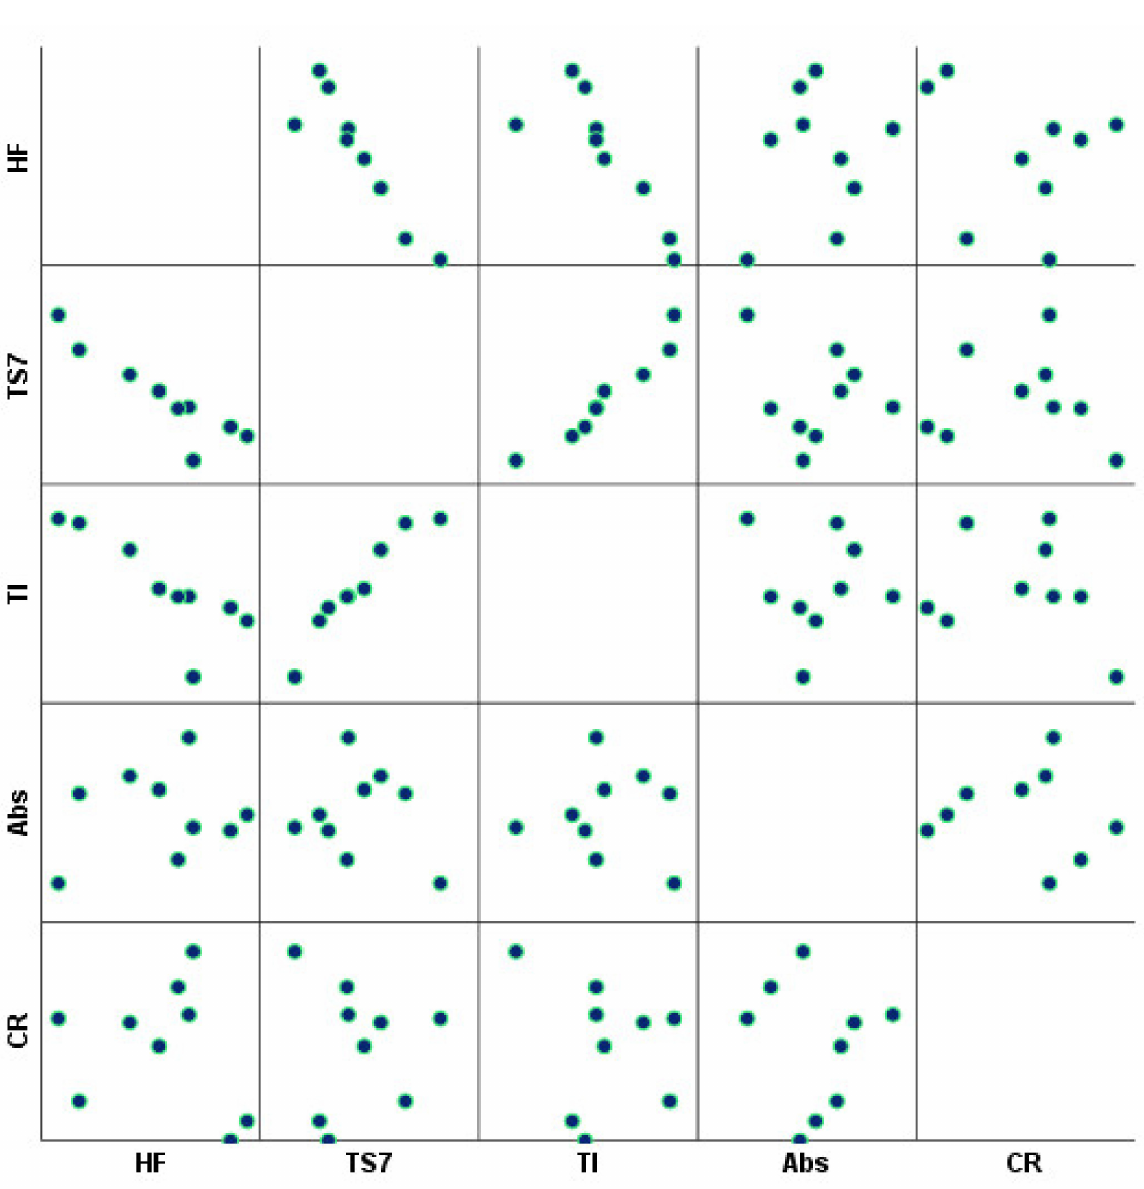
Figure 11. Correlation matrix of each functional